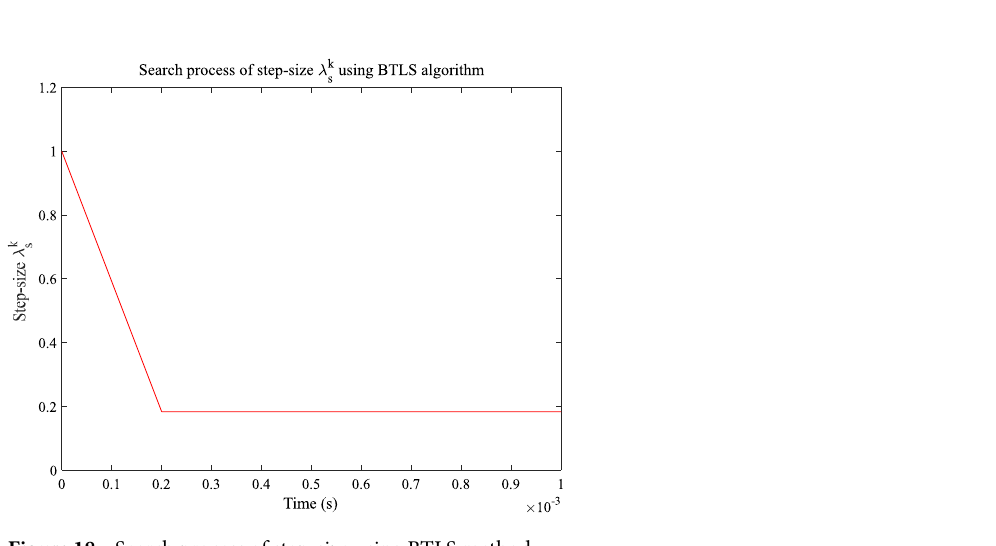
Figure 18. Search process of step-size using BTLS